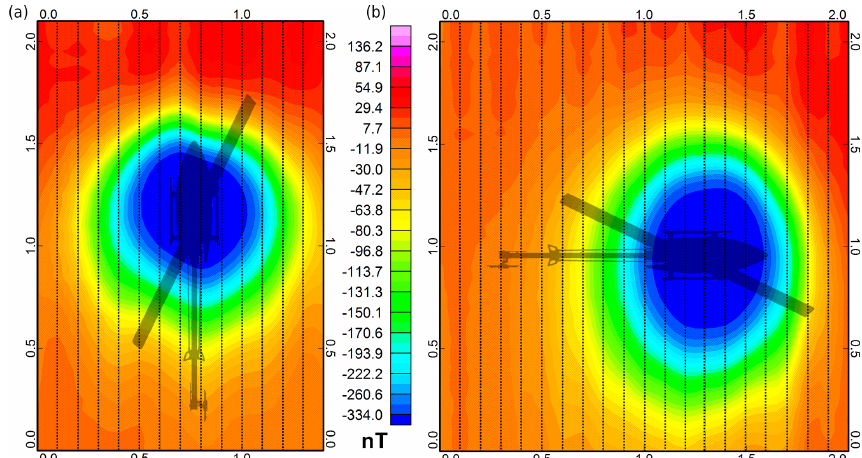
Figure 5. Interference map of the SRH facing magnetic north (a) and east (b) . Border units are in